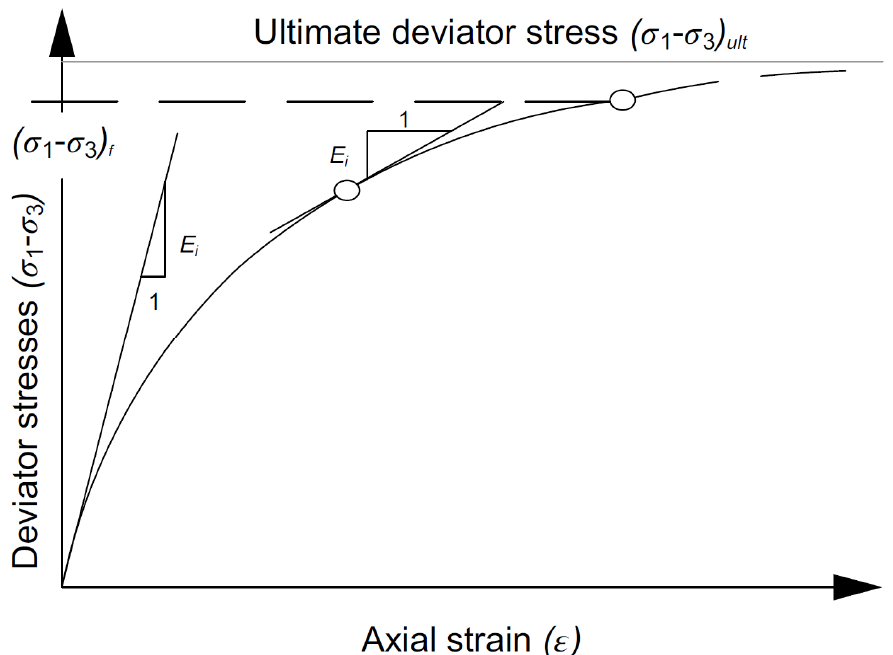
Figure 7. Duncan–Chang nonlinear hyperbolic constitutive model of soil for bridge #I and #II.